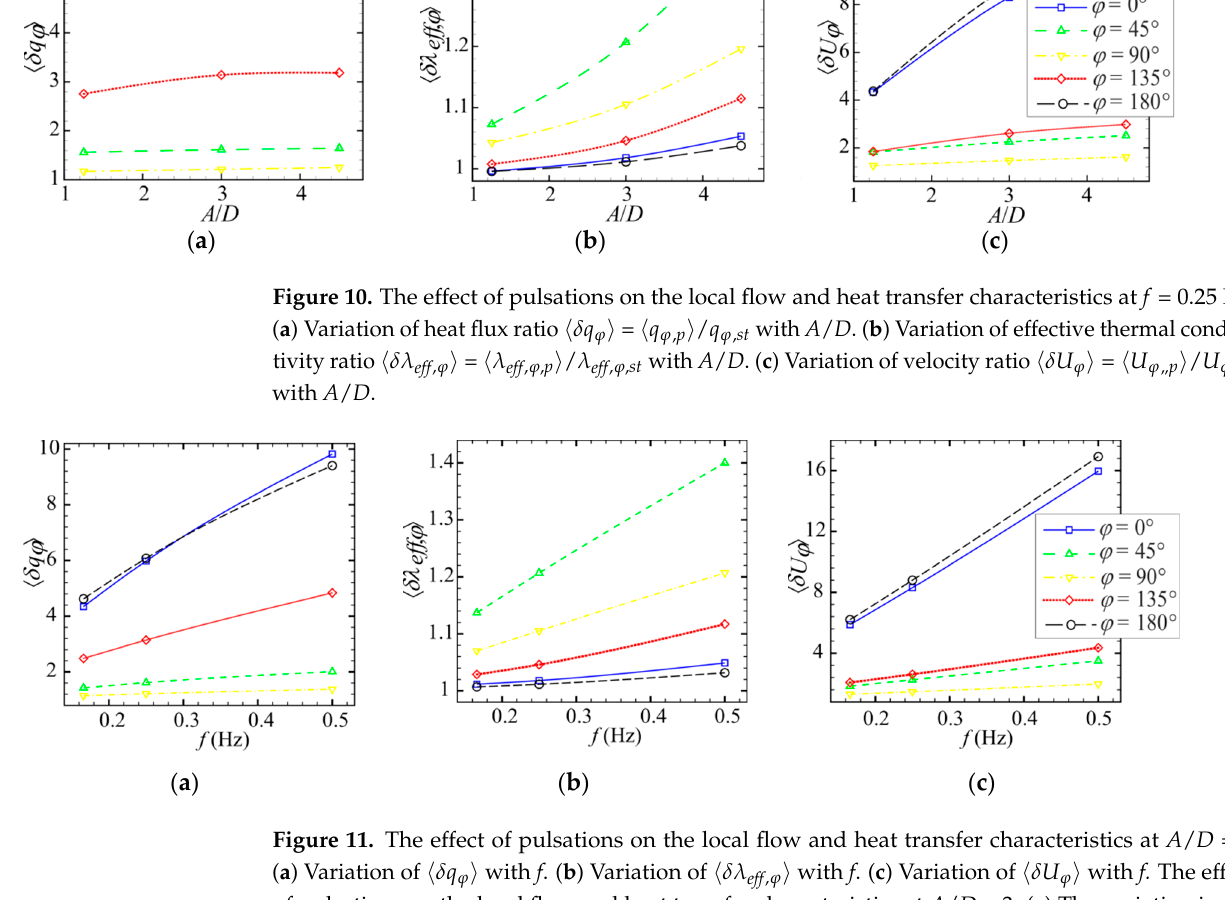
( b ) Figure 12. The effect of pulsations on the local Nusselt number. ( a ) Variation in the Nusselt number ratio  δ Nu φ  =  Nu φ , p  / Nu φ , st with A / D at f = 0.25 Hz. ( b ) Variation of  δ Nu φ  =  Nu φ , p  / Nu φ , st with f at A / D = 3. In the in-line tube bundles with a steady flow between the rows of the tube, regions with low circulation are formed. As a result, the heat transfer in these areas is reduced [32,33]. An increase in the intensity of pulsations leads to an increase in the fluid circula- tion in these areas (Figures 10c and 11c). Therefore, with an increase in the intensity of the pulsations, an increase in heat transfer occurs in the front ( φ = 0°) and back ( φ = 180°) areas of the cylinder. The local dynamics of the instantaneous values of δ U φ , δ q φ , δ Nu φ , δλ eff , φ are shown in Figures 13 and 14. The values of local heat flux δ q φ and local Nusselt number δ Nu φ in the front ( φ = 0°) and back part ( φ = 135°, 180°) of the cylinder increased up to 14–29 times, which is consistent with an increase in the values of δ U φ . The instantaneous value of the local Nusselt number at the front of the cylinder ( φ = 0°) increased up to 29 times (Figure 14d) during the first pulsation period T 1 , which corresponded to the reciprocating flow. The augmentation of the instantaneous values of the local Nusselt number in the front part of the cylinder was associated with the restructuring of the flow structure, as the result of the reciprocating flow. The maximum augmentation of δ Nu φ in the back of the